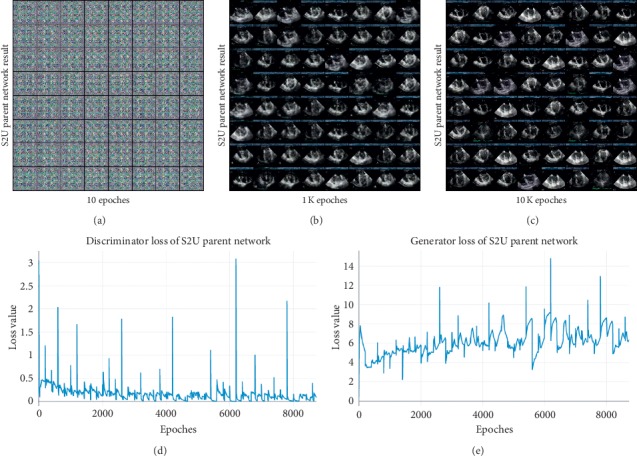
S2U training phase.